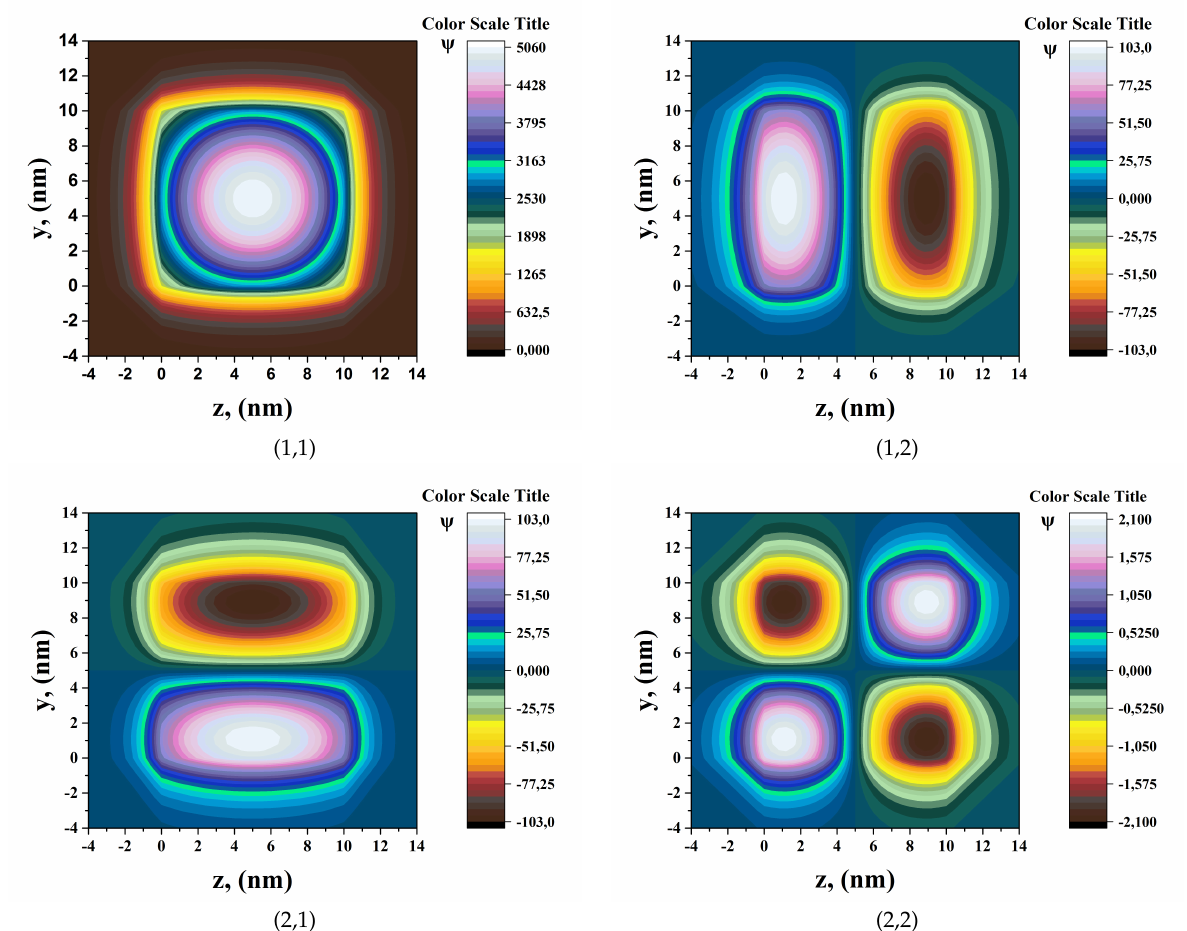
Fig. 3. Dependence of the electron energy in a rectangular nanowire with a finite potential well on the size of the well